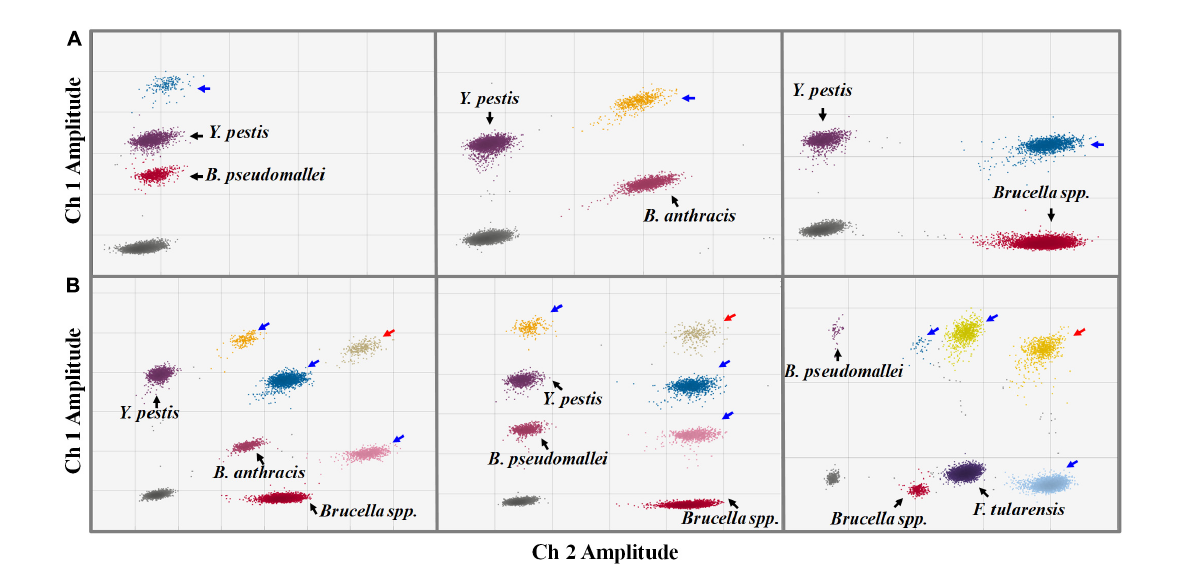
FIGURE5 Simultaneous detections of two (A) and three (B) kinds of targets in one sample by the ddPCR assay (2D plot). The x -axis refers to fluorescence amplitude in the FAM channel; the y -axis refers to fluorescence amplitude in the HEX channel. The droplet clusters marked by black, blue, and red arrows refer to positive droplets containing a single target, two different targets, and three different kinds of targets, respectively.